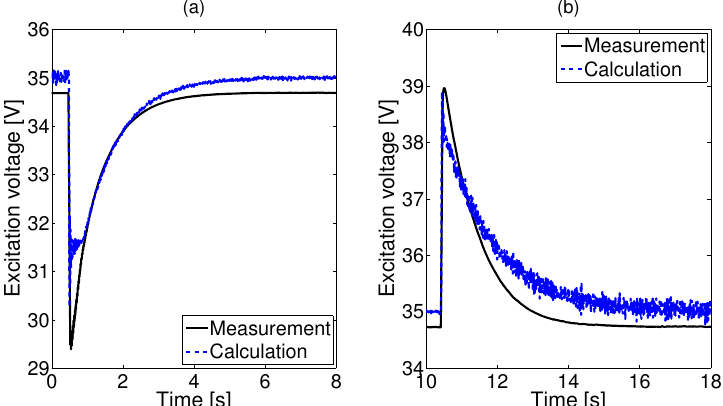
Figure 11. Comparison of the measured and calculated excitation voltage of the synchronous genera- tor during active-reactive load switched on ( a ) and off ( b